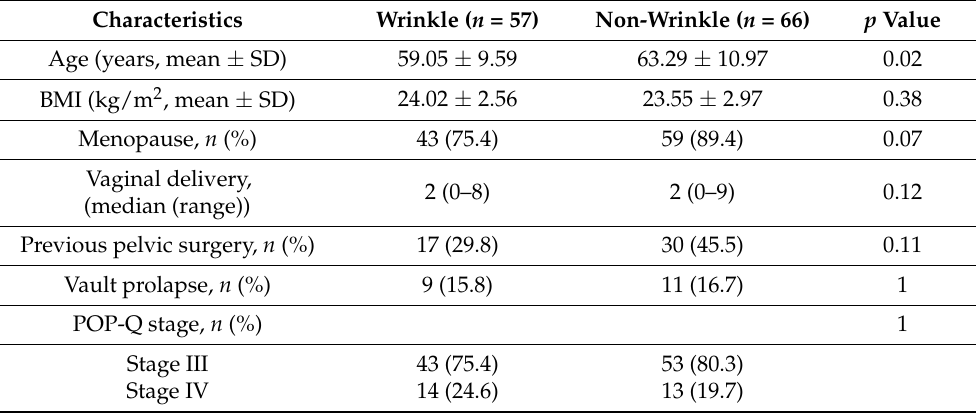
Table 1. Patient baseline characteristics.